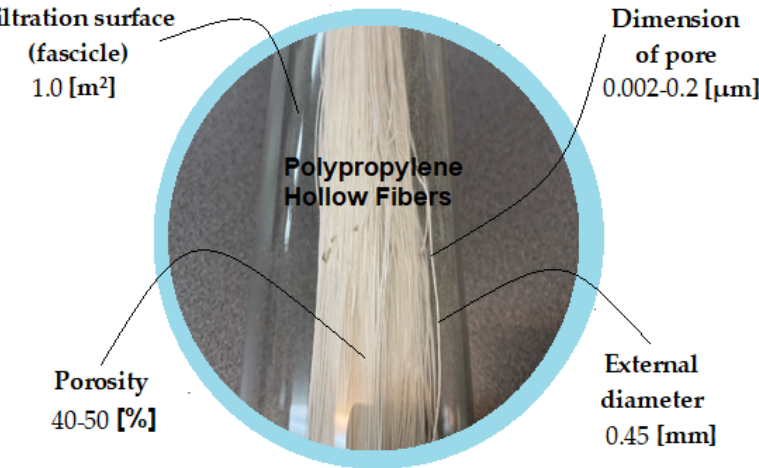
Figure 2. The characteristics of the hollow fibers polypropylene support membranes (PPM).